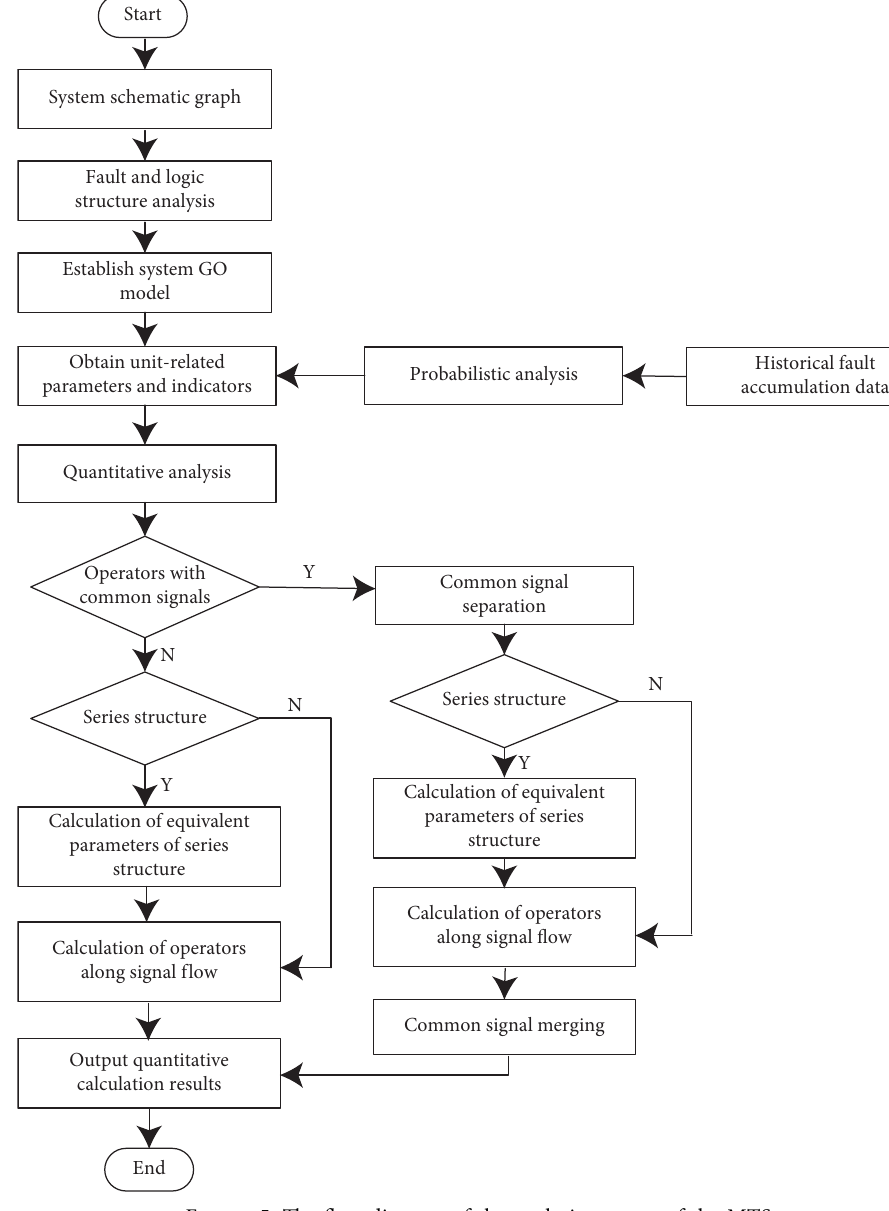
Figure 5: The flow diagram of the analysis process of the